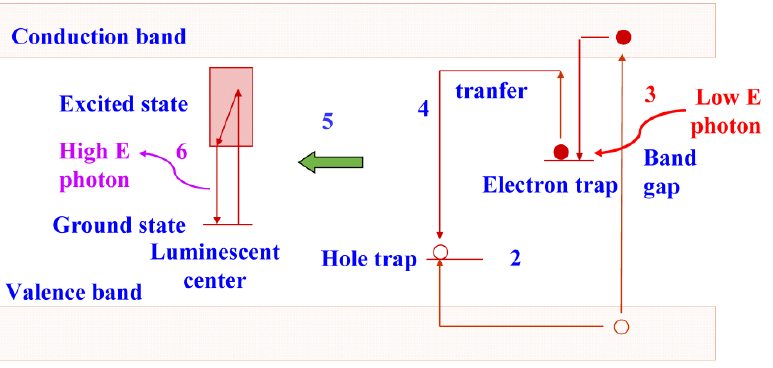
Figure 3. Energy diagram showing photo-stimulated luminescence in a storage phosphor.